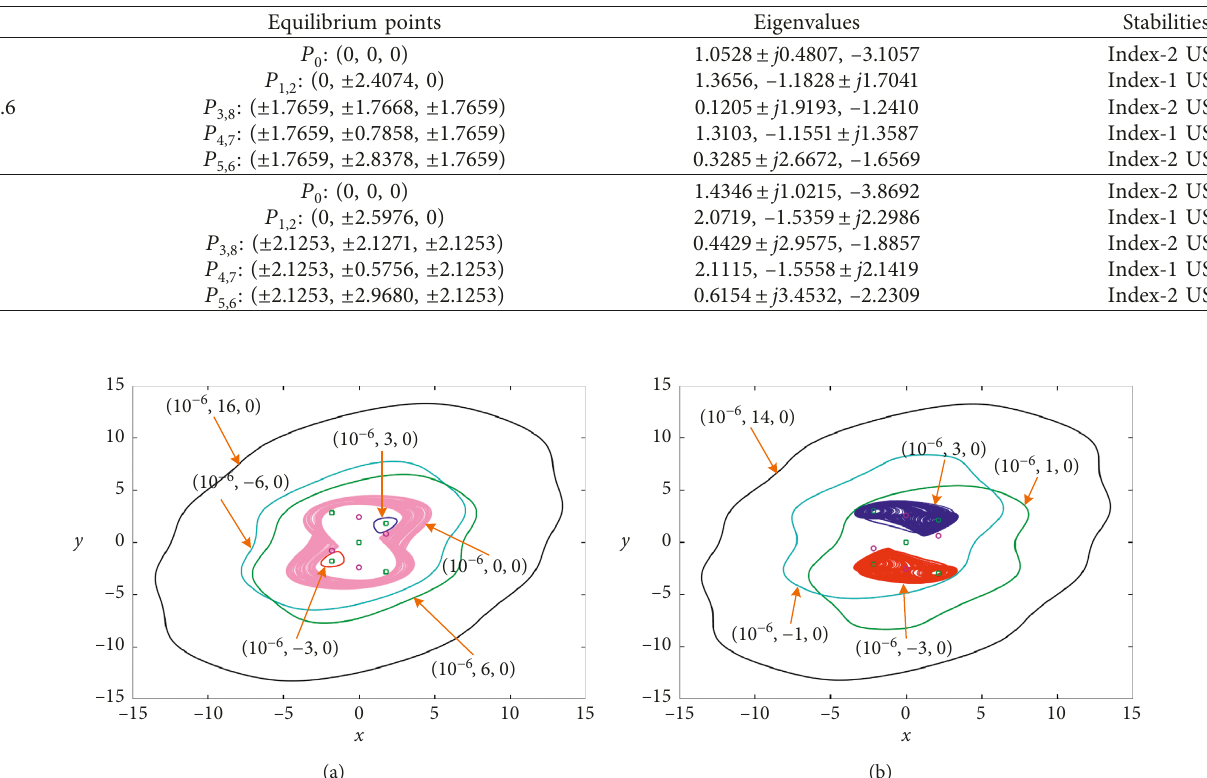
3.6, six types of (cid:31)